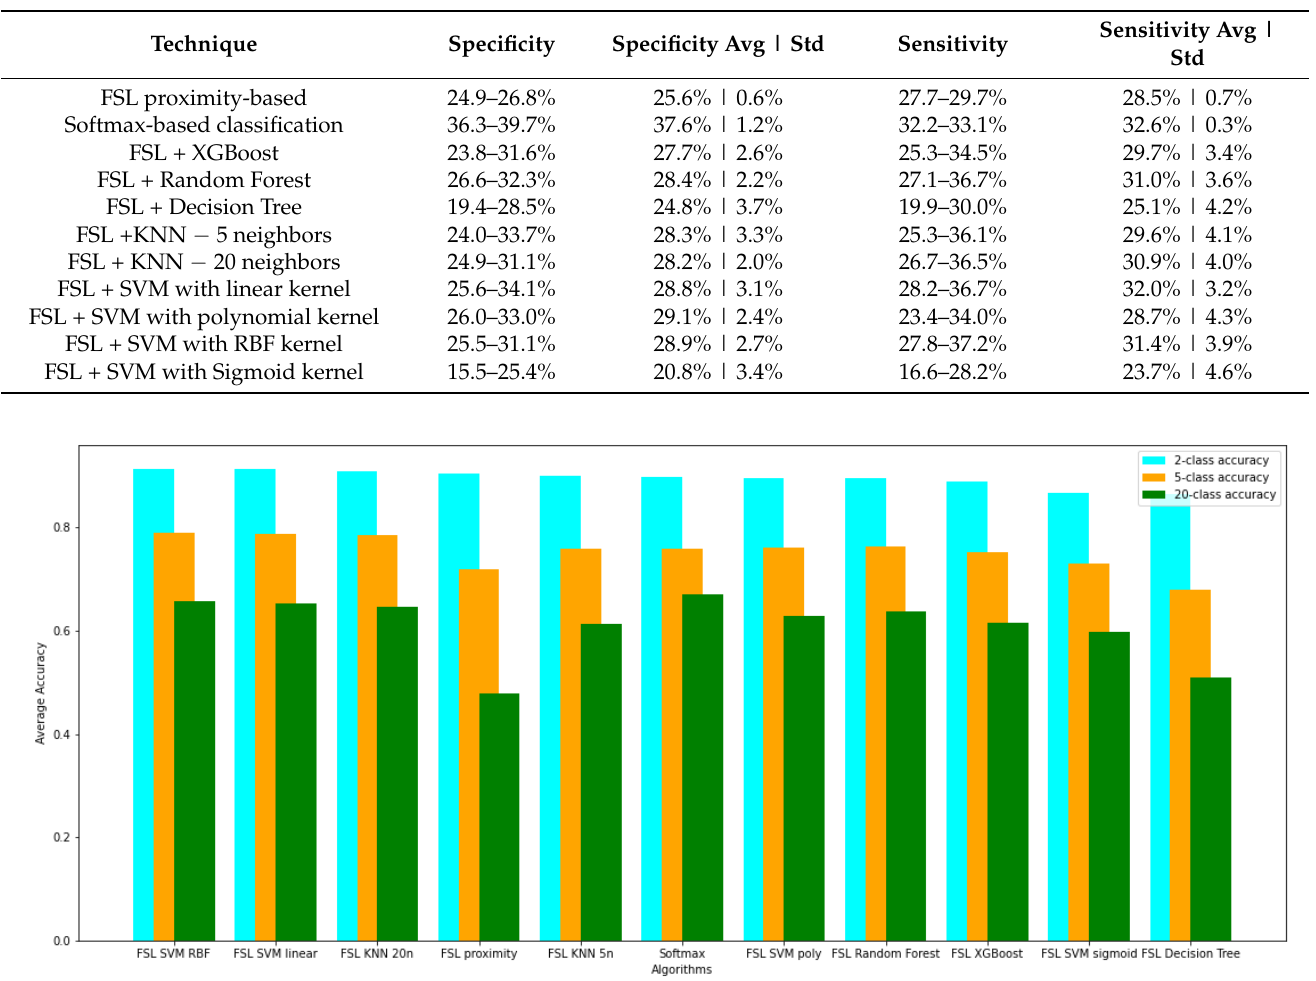
Table 7. Results for 20-class classification, part II.